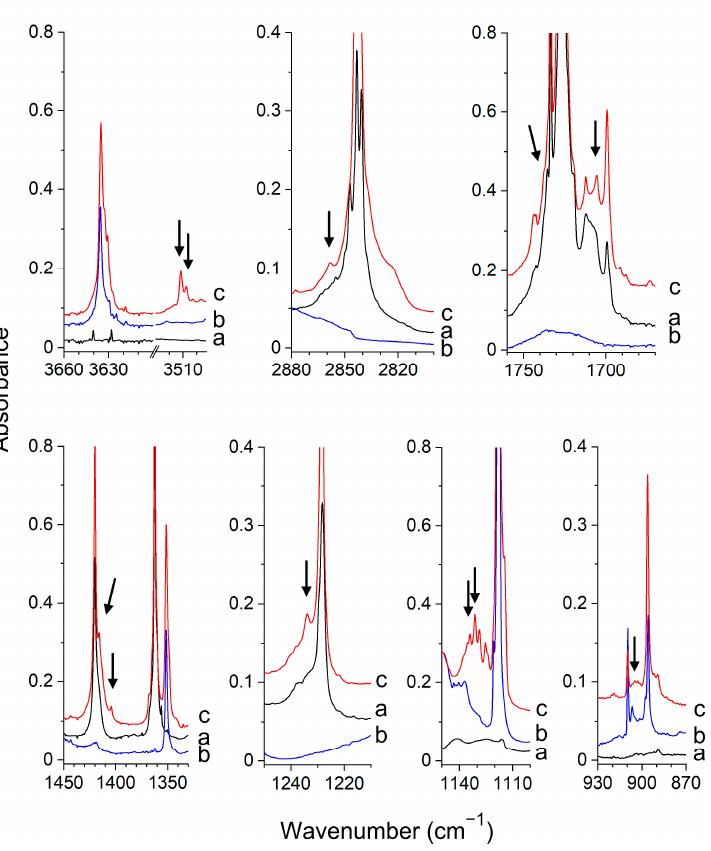
Figure 7. The spectra of the CH 3 COCHO/Ar ( a ), NH 2 OH/Ar ( b ) and CH 3 COCHO/NH 2 OH/Ar ( c ) matrices recorded after matrix deposition at 11 K. The bands of the CH 3 COCHO–NH 2 OH complex are indicated by the arrows.